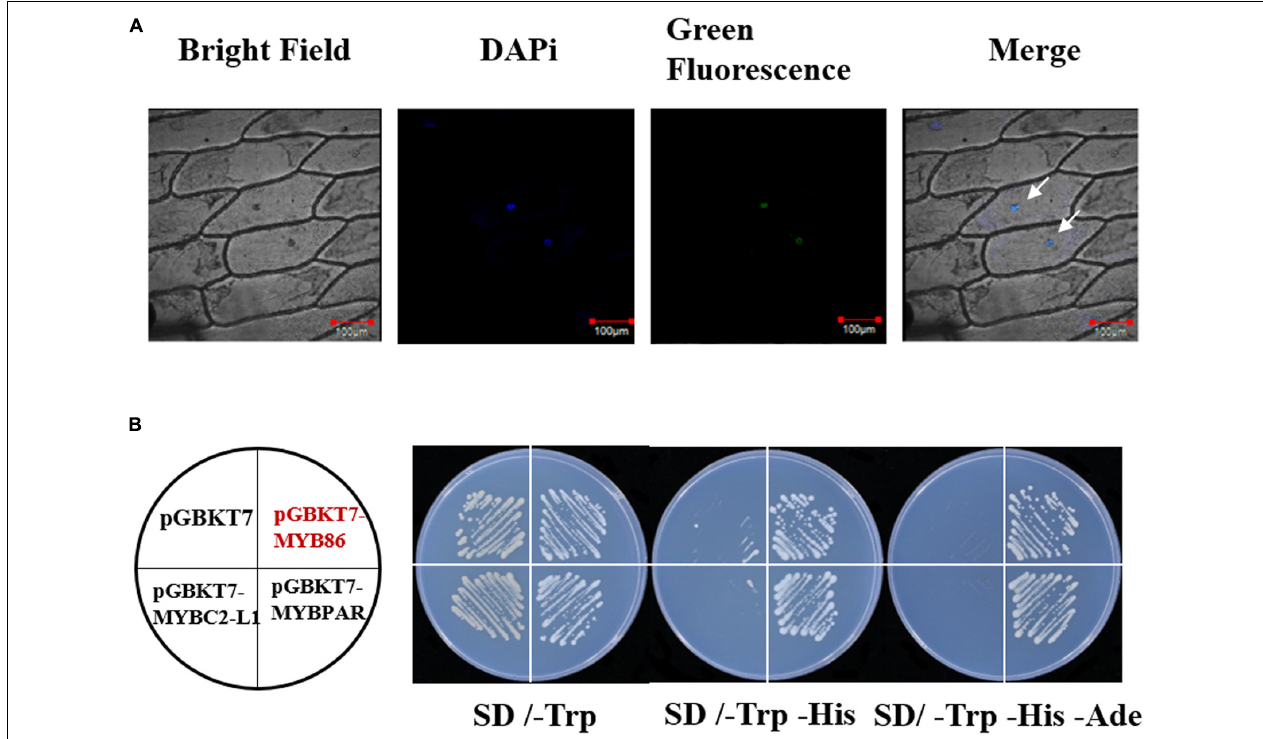
FIGURE 2 | Subcellular localization of VviMYB86 and its transcription activation. (A) GFP activity in onion epidermal cells transiently expressing a VviMYB86-GFP construct. Bar: 100 µ m. GFP, green fluorescence channel; Marker, blue fluorescence channel; DIC, bright light channel; Merge, the GFP and DAPi overlap. Arrows were the sites of GFP and DAPi overlap. (B) Transcription activation by VviMYB86 in yeast. The pGBKT7-VviMYBPAR plasmid was employed as a positive control. The pGBKT7-VviMYBC2L1 and pGBKT7 plasmids were employed as the negative controls. SD/-Trp, SD medium lacking tryptophan; SD/-Trp –His, SD medium lacking both tryptophan and histidine; SD/-Trp –His -Ade, SD medium lacking tryptophan, histidine, and